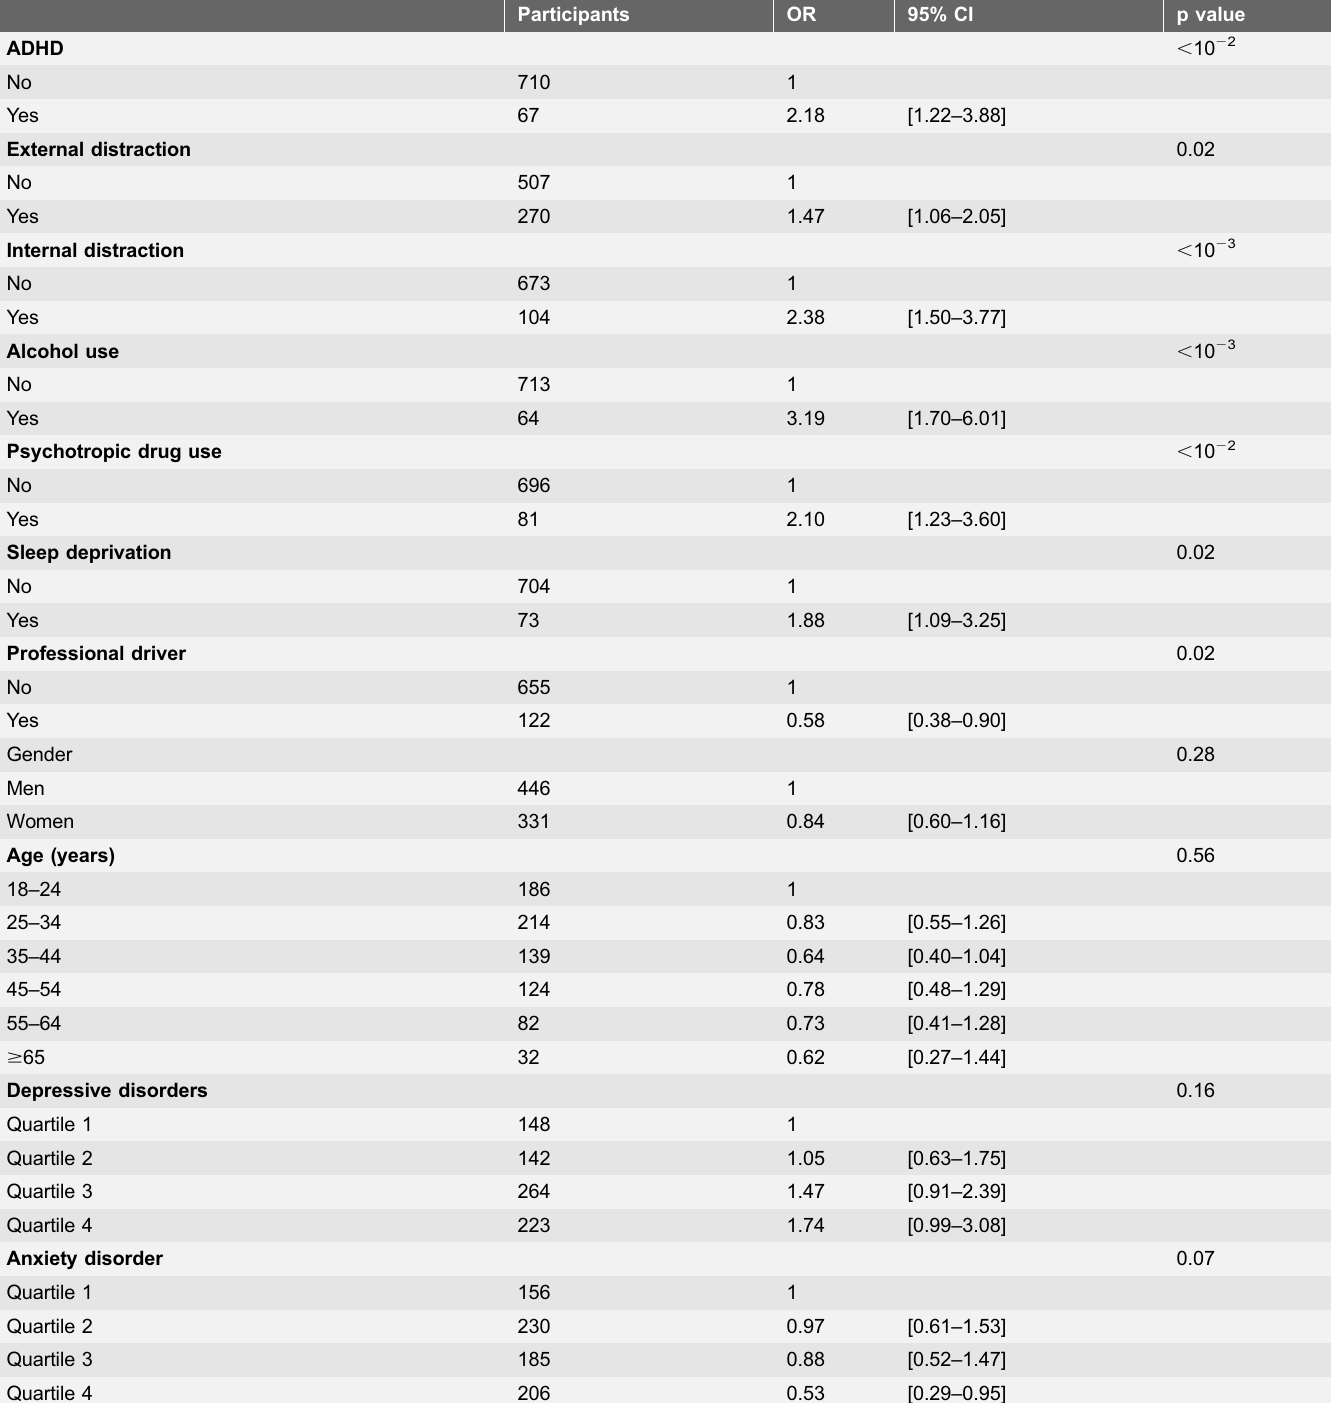
Table 2. Factors associated with driver responsibility for road traffic crashes, multivariate logistic regression (n 5 777).